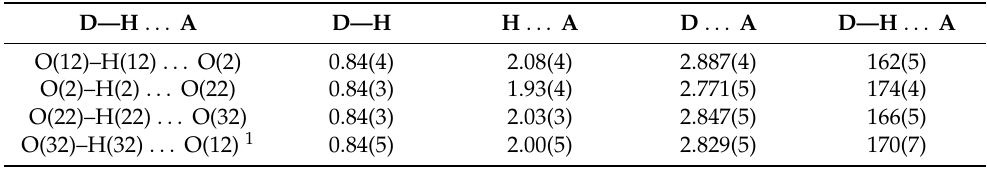
Figure 2. Structure of the two independent molecules showing numbering and the basic hydrogen bonding pattern. Table 1. Hydrogen bonding parameters for 1 (Å, ◦ ).